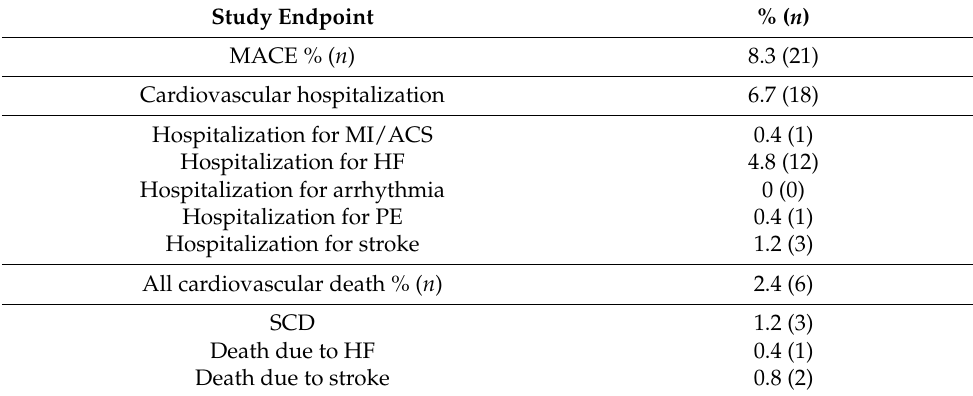
Table 2. Characteristics of MACE during follow-up.